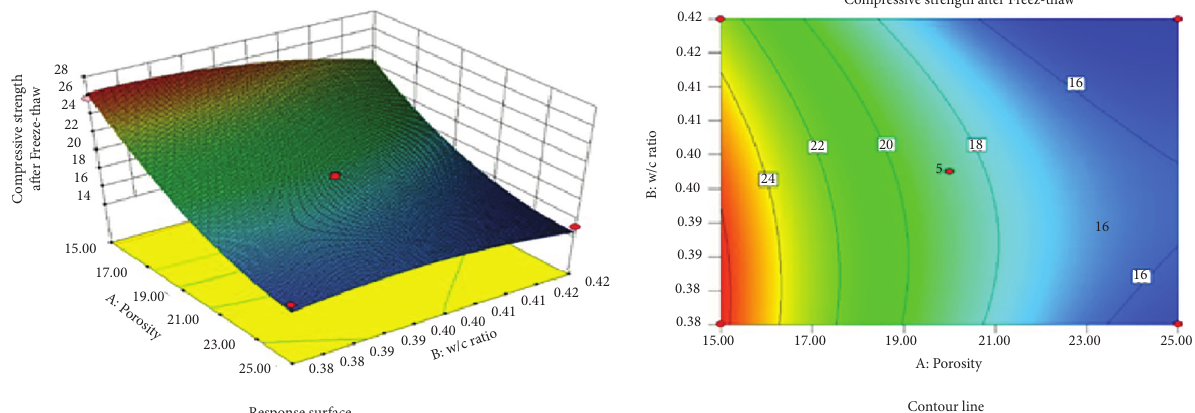
Figure 5: Influence of porosity A and w/c ratio B on compressive strength after freeze-thaw.